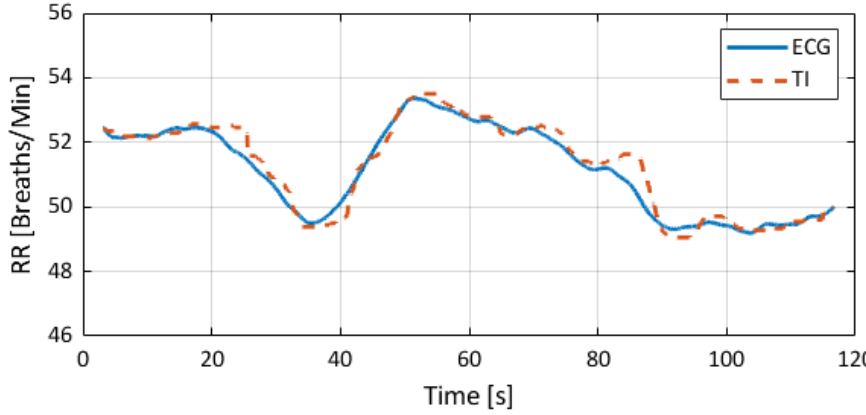
Figure 5. Estimated RRs. The solid line stands for the gold standard (RR derived from ECG), and the dashed line corresponds to the RR obtained with thermal imaging.